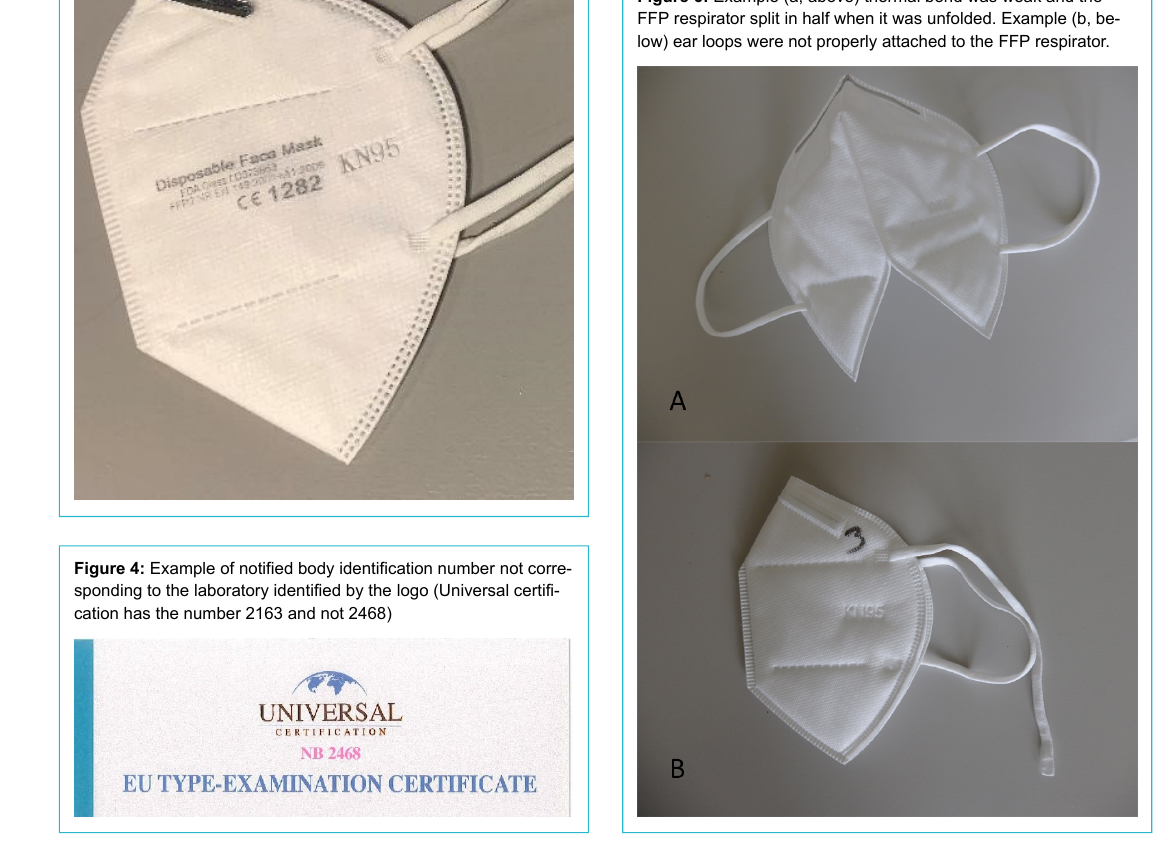
Figure 6: Example (a, above) thermal bond was weak and the FFP respirator split in half when it was unfolded. Example (b, be- low) ear loops were not properly attached to the FFP